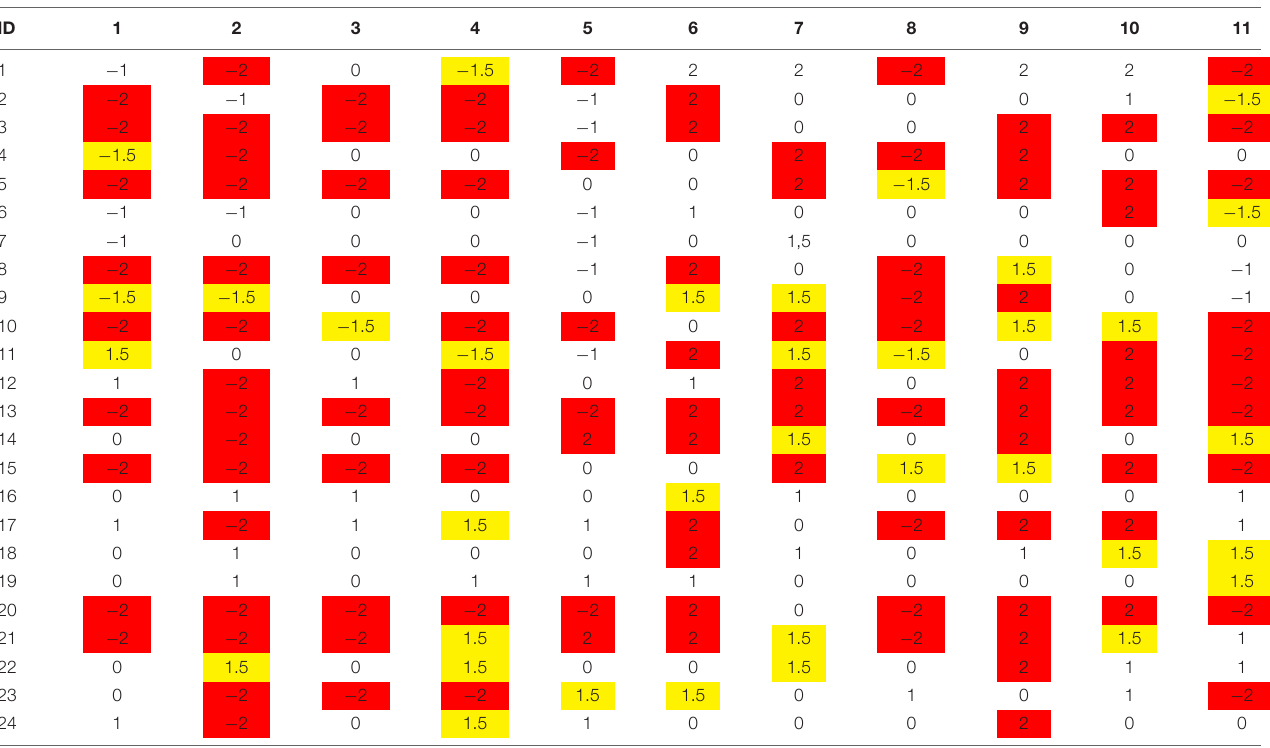
Table showing the z-scores of each participant with ASD on each linguistic measure. Z-scores highlighted in yellow show performances of about 1.5 SDs above (in case of errors) or below expected means. Z-scores highlighted in red show performances of about at least 2 SDs above (in case of errors) or below expected means.